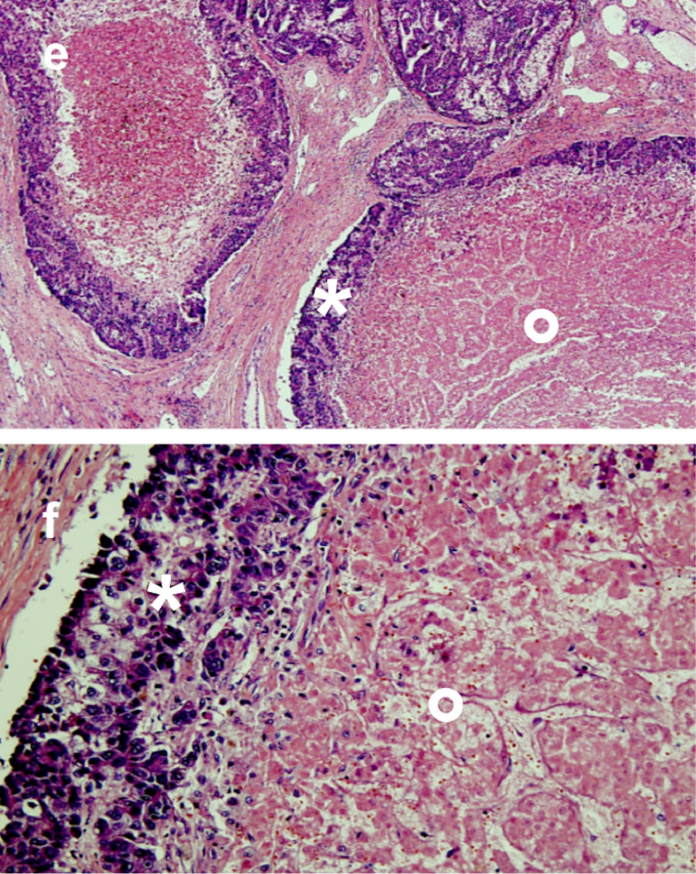
Figure 1. Bridging of HCC with TACE. Small HCC in hepatic segment 6 (arrow) at ( a ) pre-treatment CT scan in arterial phase and ( b ) at digital subtraction angiography. Complete radiological response was depicted at one-month CT evaluation after p-TACE (arrow) without appreciable enhancing tis- sue in ( c ) arterial and ( d ) portal-venous phase. The patient underwent liver transplantation two years after p-TACE. At pathologic examination of the explanted liver ( e – f ), extensive necrosis (*) was found in the treated area with presence of peripheral viable tumor tissue ( ο ) ( e : magnification 20×; f : magnification 40×)